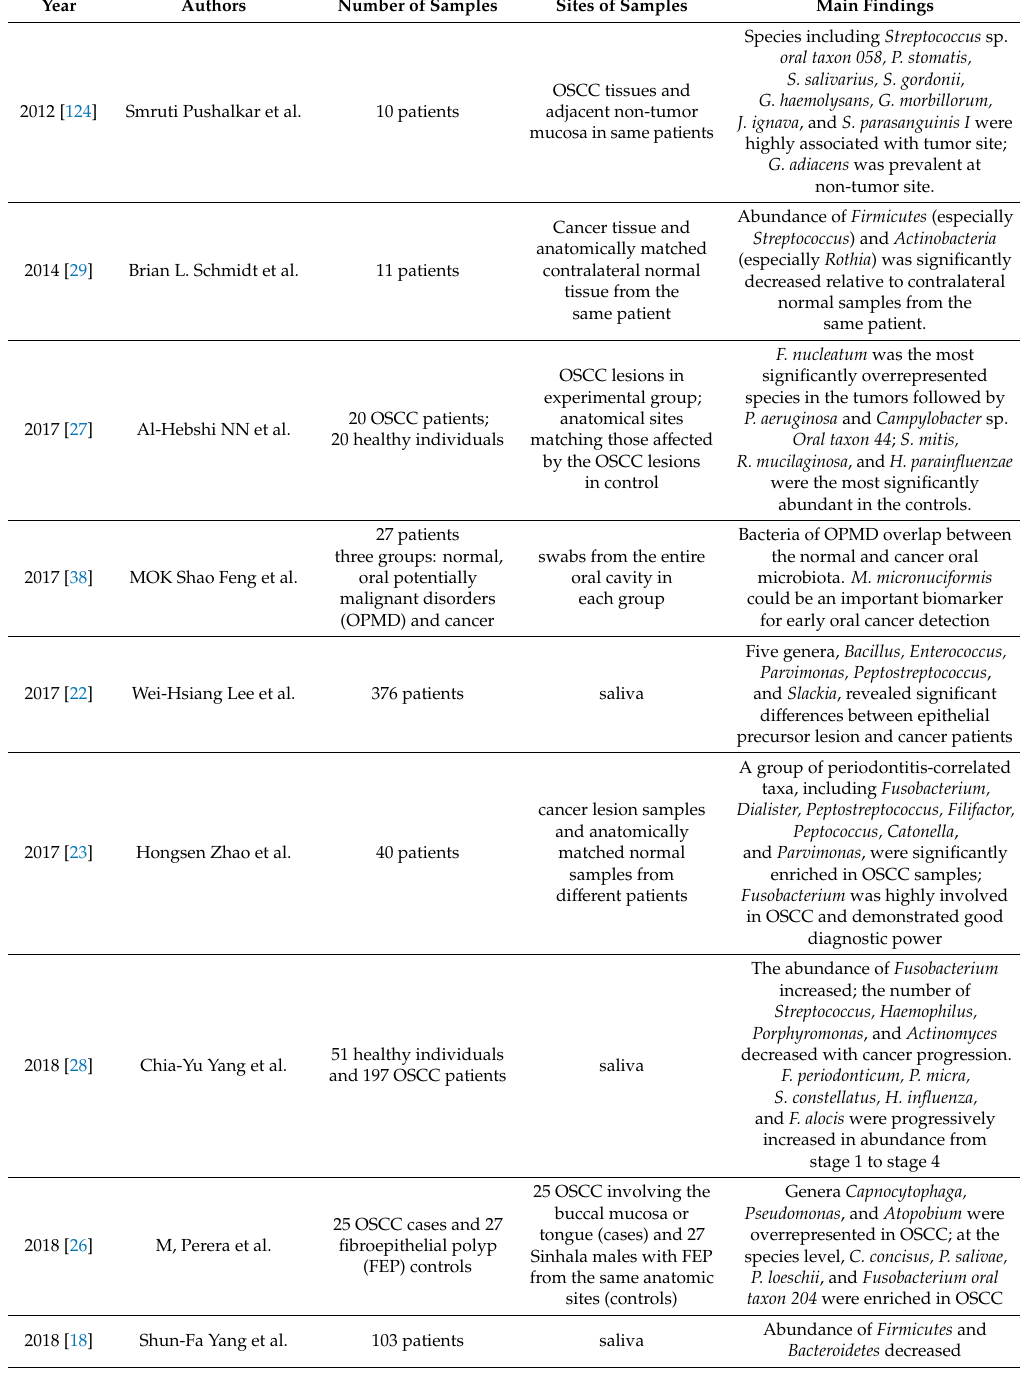
Table A1. Sum-up of recent 10-year research findings of noticed changing oral bacteria in oral squamous cell carcinoma